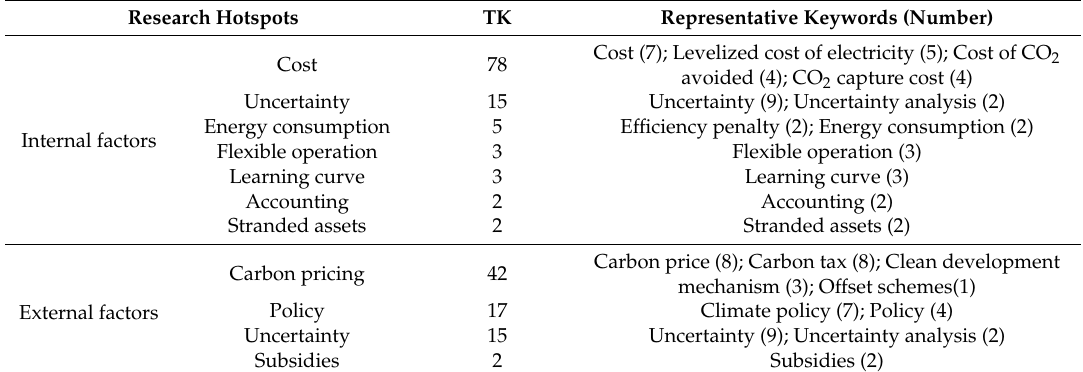
Table 9. Internal and external factors introduced and representative keywords. Representative Keywords